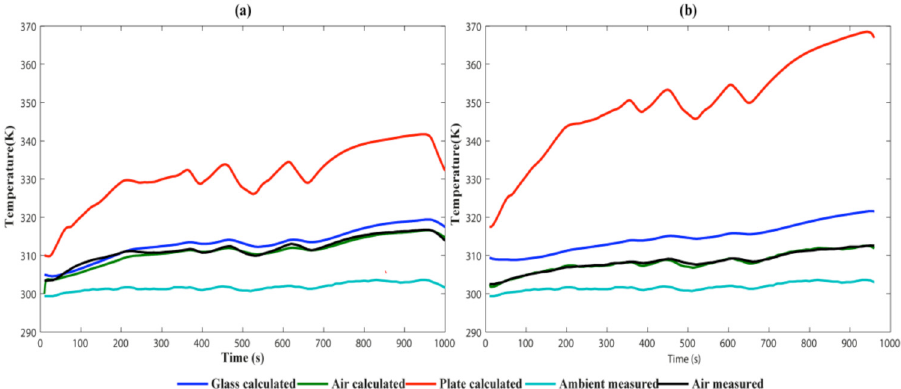
Fig. 3. Comparison between the calculated and measured temperatures when m a = 0.33 kg/s, of (a) “ V ” -porous absorber plate and (b) “ U ” -corrugated absorber plate,